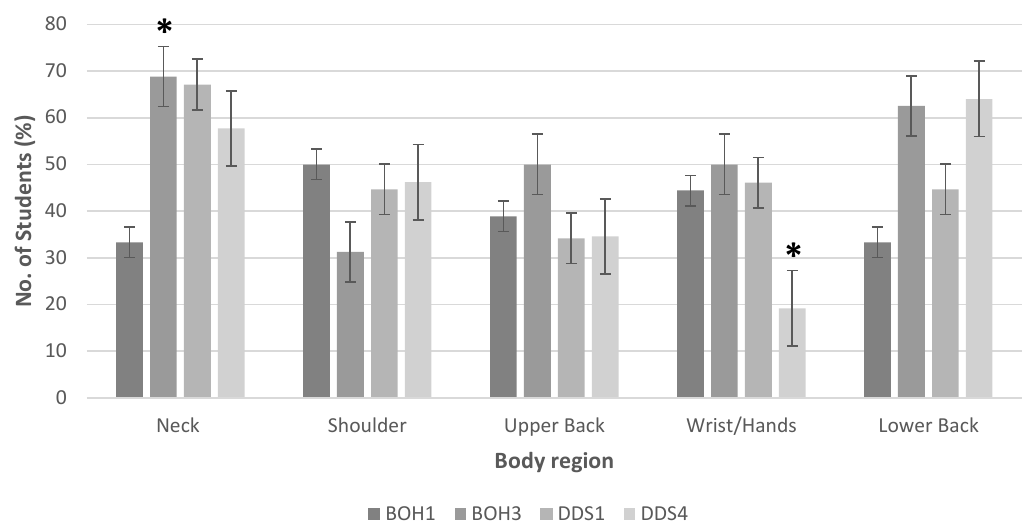
Figure 1. MSD prevalence of body regions between the cohorts studied. * p -value < 0.05. Statistical correlates of MSD were differentiated into two tables, with the predictors shown in Table 6 and the protective factors shown in Table 7. Table 6. Statistical correlates and predictors of MSD.